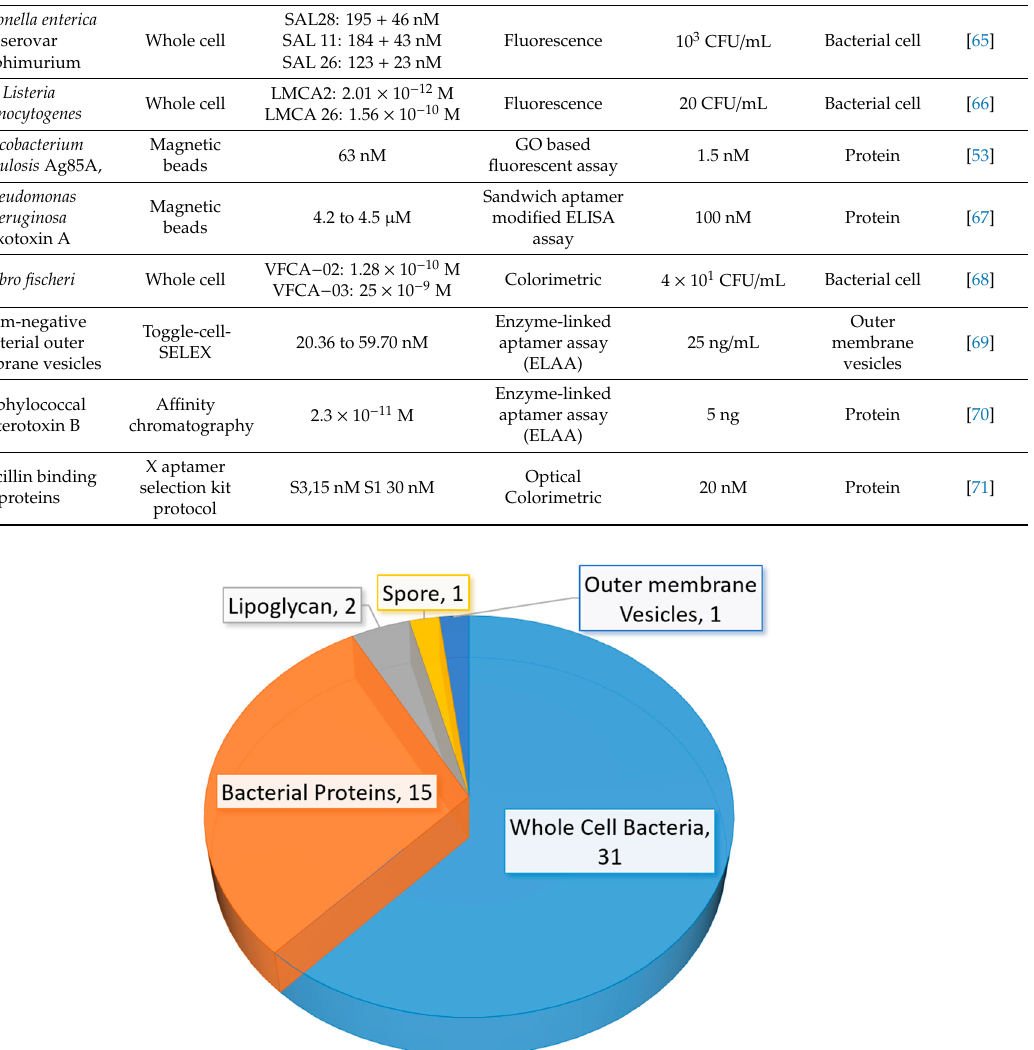
Figure 6. A graphical representation of the number of newly identified aptamers against bacteria and related factors from mid-2015 to early 2020. This pie chart includes aptamers from both Tables 1 and 2. Table 3. Summary table of new ssDNA aptamer-based biosensors intended for the diagnostic of bacterial infection in humans.